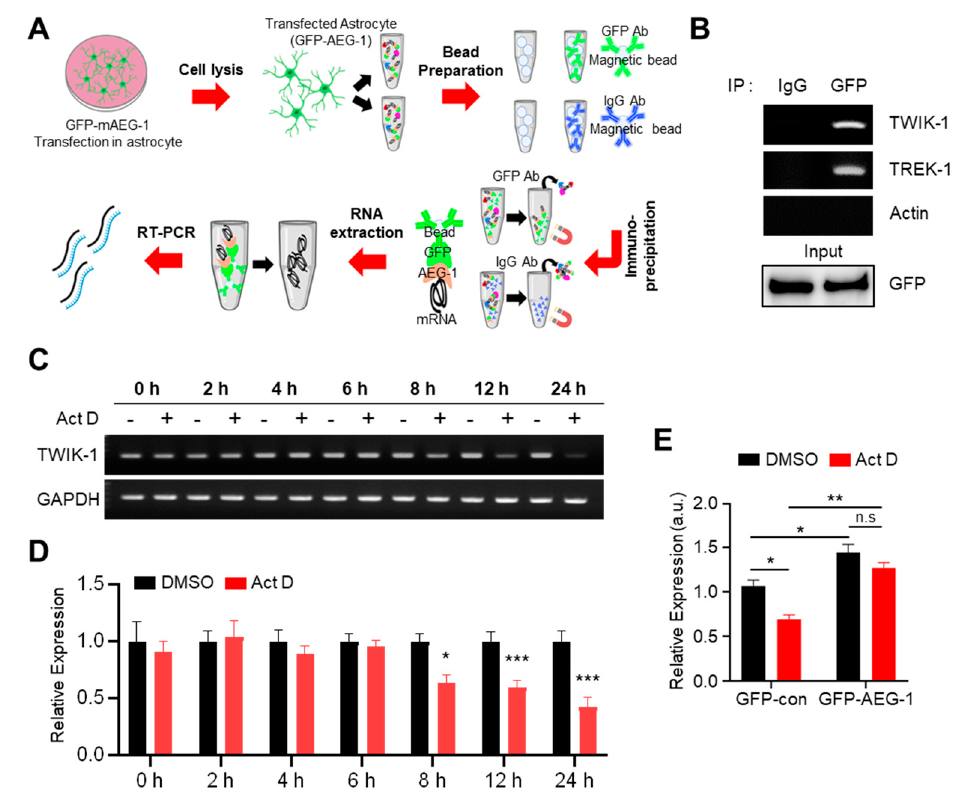
Figure 4. AEG-1 binds with TWIK-1 mRNA and enhances its mRNA stability. ( A ) Scheme of the RIP assay. ( B ) Immunoprecipitation of TWIK-1, TREK-1, and actin (negative control). RIP assay was performed on transfected astrocytes with GFP-AEG-1. Immunoprecipitation was performed with mouse IgG and GFP antibodies. Total RNA was purified, and TWIK-1 and TREK-1 mRNAs were detected by RT–PCR. Five percent of the total lysate was used as an input control. Actin was used as the negative control. Primary cultured astrocytes were incubated with Act D (5 µ g/mL), and total RNA was harvested after various incubation times. TWIK-1 mRNA levels were determined using RT-PCR ( C ) and normalized to the GAPDH ( D ). Data show the mean ± SEM. * p < 0.05, *** p < 0.001 (Student’s t-test). ( E ) Relative expression levels of TWIK-1 mRNA after additional 8 h incubation with Act D (5 µ g/mL) in transfected astrocytes with GFP-AEG-1. Total RNA was harvested from astrocytes after eight hours of incubation. Data are presented as mean ± SEM. * p < 0.05, ** p < 0.01. P-values were obtained from the two-way ANOVA with Tukey’s multiple comparison post hoc test.